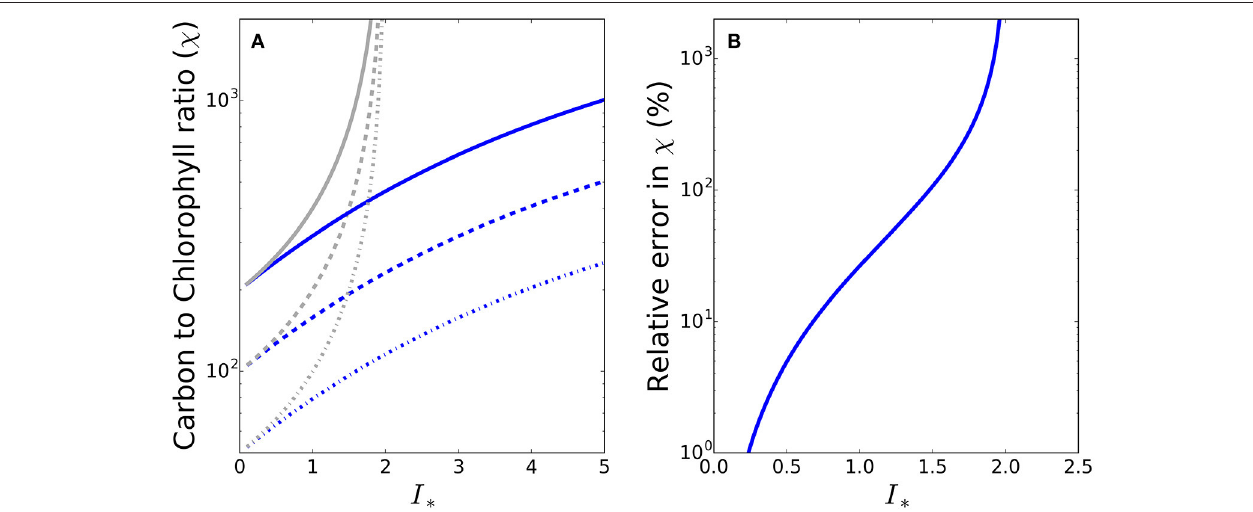
FIGURE 1 | (A) The divergence of the approximate (gray) and exact (blue) solution estimates of the C:Chl ratio as a function of I * . Solid, dotted and dot-dash lines are for θ m values of 0.005, 0.01, and 0.02 respectively. The exact solution is clearly stable across the full range of I * values, while the approximate solution is not. (B) The relative difference between the approximate and the exact solutions as a function of I *